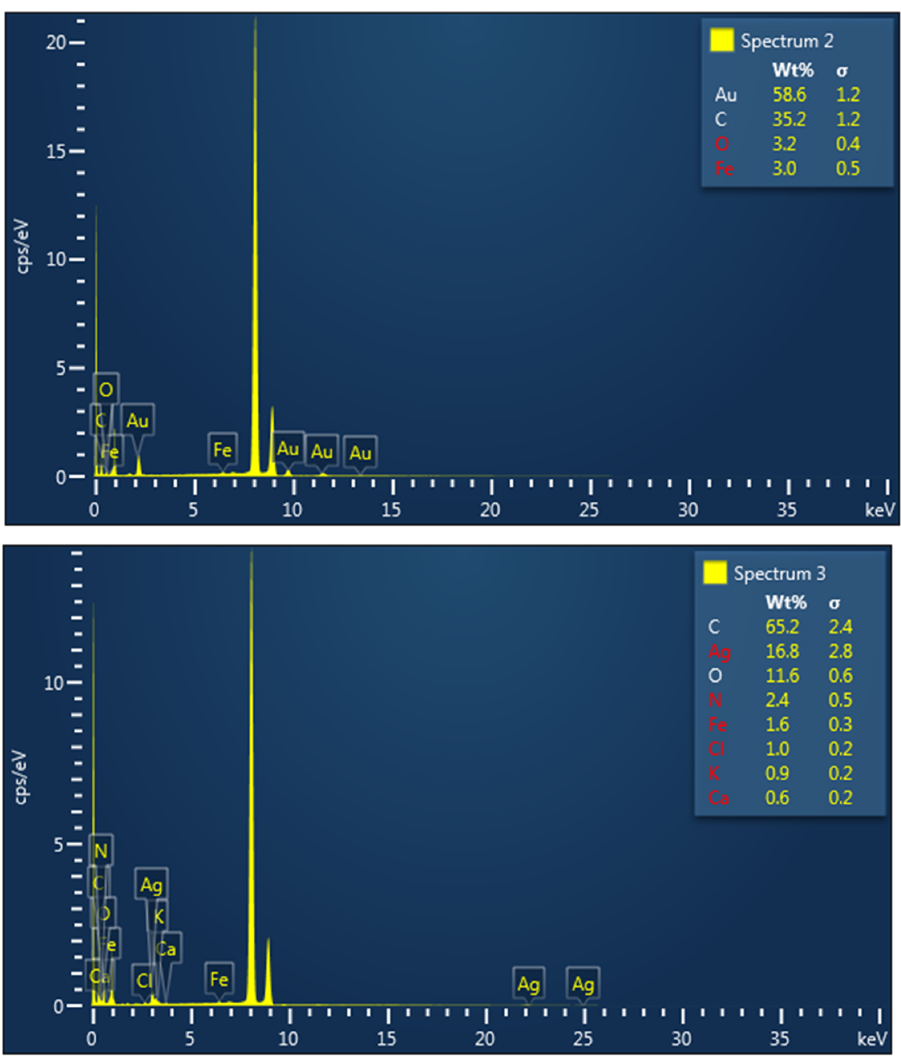
Figure 6. EDX (energy dispersive X-ray diffraction) analysis for silver and gold nanoparticles biosynthesized with Cornus mas fruit extract as source of reducing and capping agents.